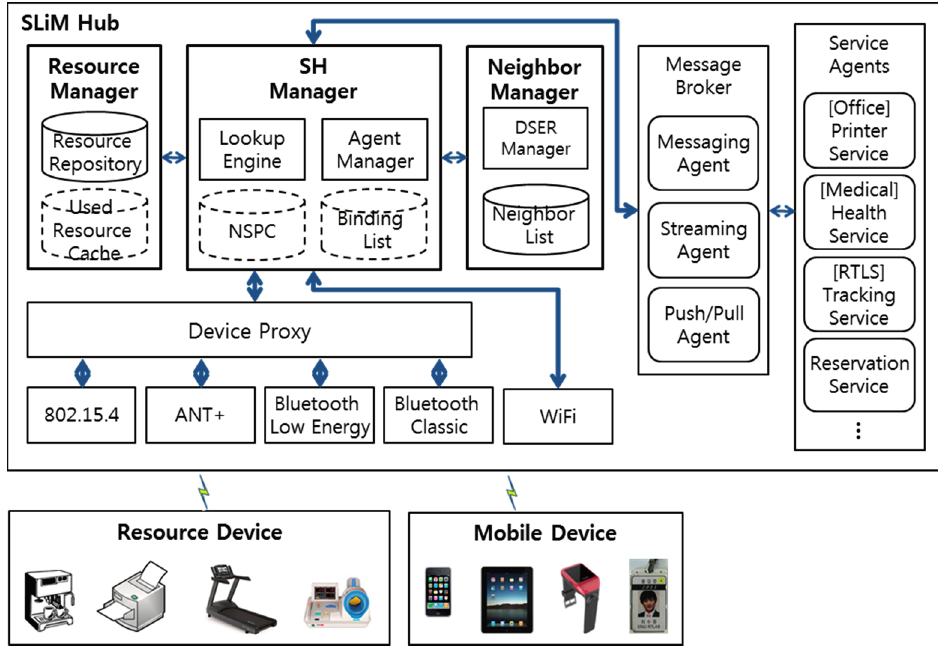
Figure 4. SoSp composition and SLiM Hub software